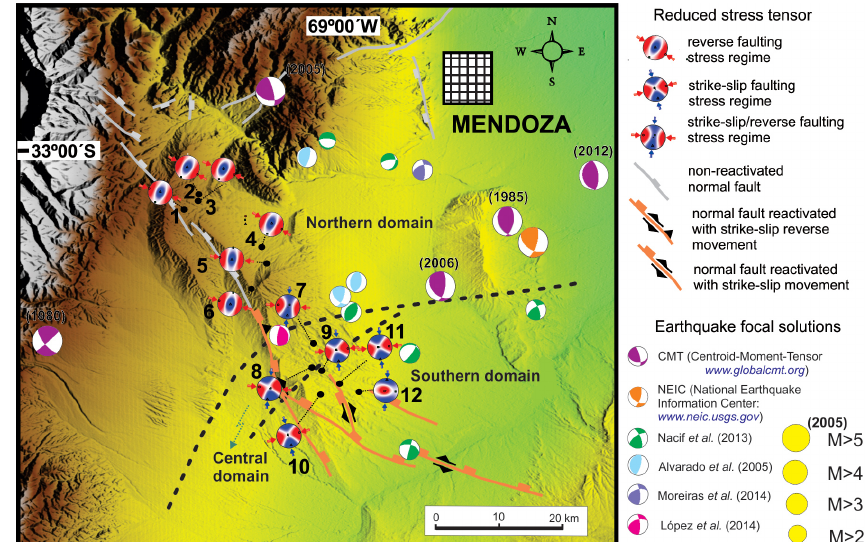
Figure 12. Dynamic analysis results (reduced stress tensors), compared with earthquake focal mechanisms obtained from CMT, NEIC, Alvarado et al. (2005), Nacif et al. (2013), López et al. (2014) and Moreiras et al. (2014). Notice the northern domain is governed by reverse faulting stress regime and compressional focal mechanisms, especially for the biggest earthquakes. To the south, seismicity abruptly vanishes, and the stress regime corresponds to a strike-slip faulting